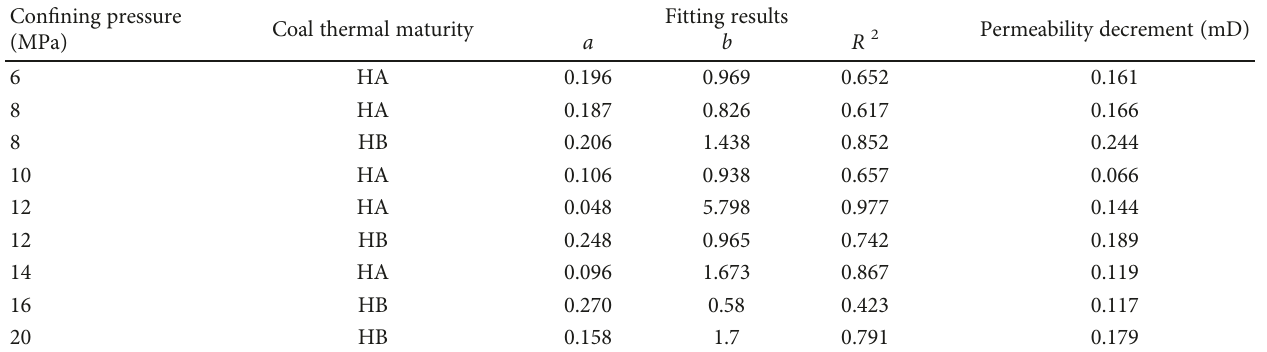
Table 5: Fitting and the calculated results of permeability increments under the e ff ect of gas